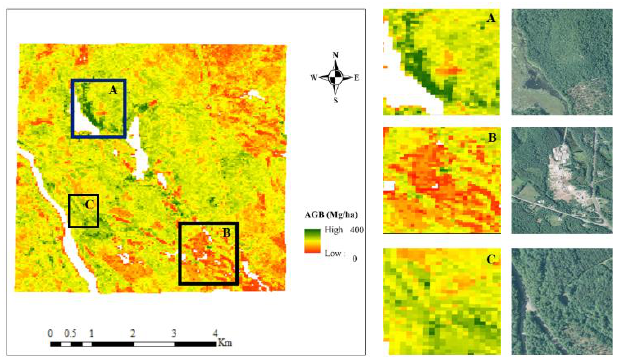
Figure 4 . Pixel-based AGB map of PDF forest using Xgboost model and optical + SAR data trained on LiDAR-derived AGB raster